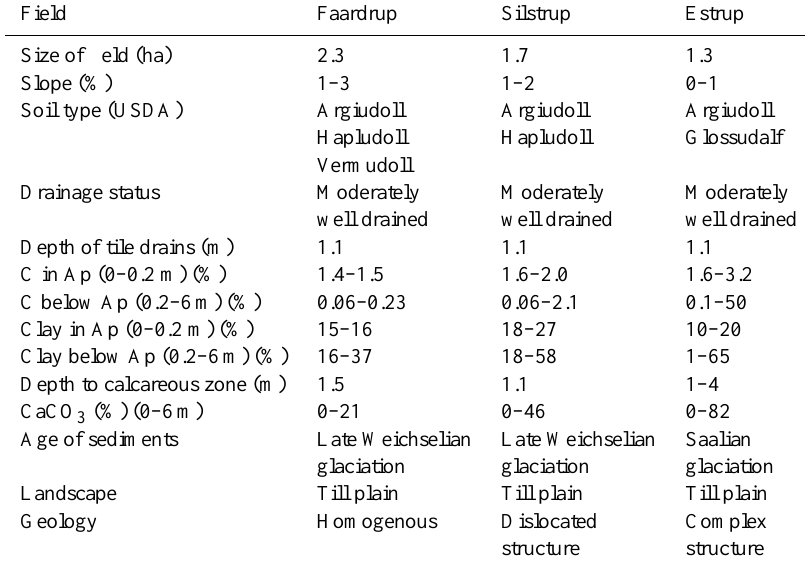
Table 2. Key parameters for the three fields according to Lindhardt et al. (2001) and Rosenbom et al. (2015).